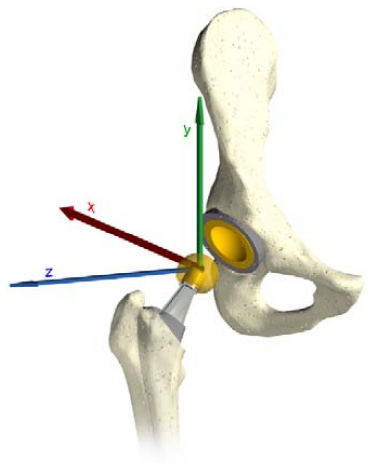
Figure 3. The three force